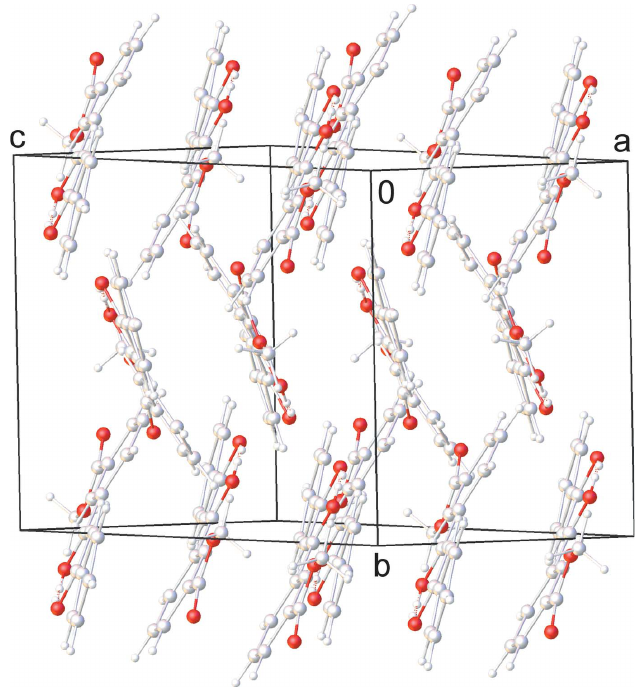
Figure 2 Crystal packing of 3-(3-hydroxy-3-phenylprop-2-enoyl)benzoate.